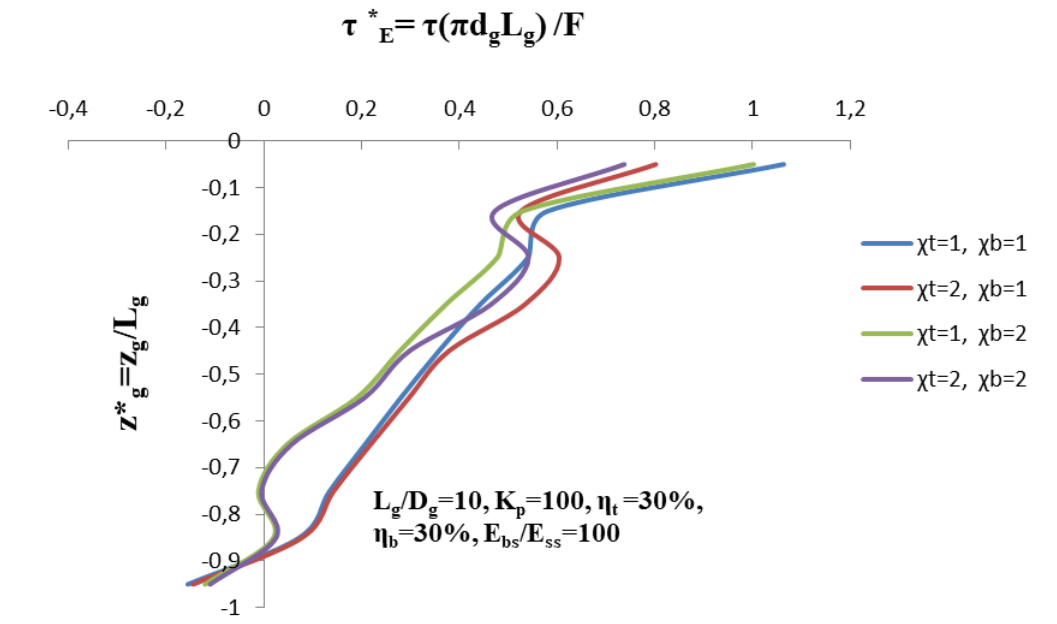
= τ(πD L )/F with normalized depth, z* E g g